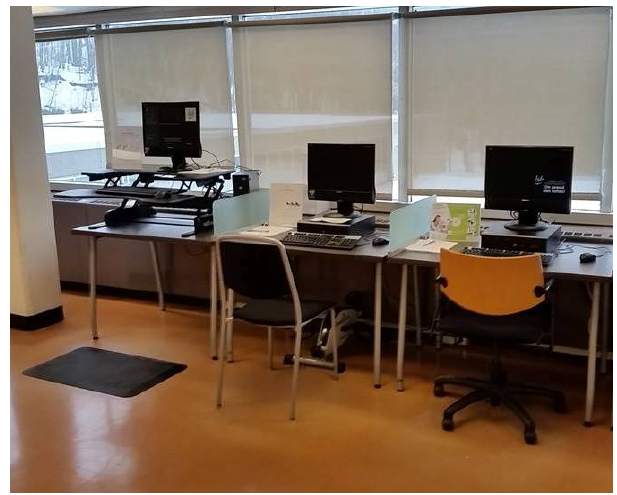
Figure 1. Setup of workstations in one of the three libraries (Kinesiology, Université de Montréal).